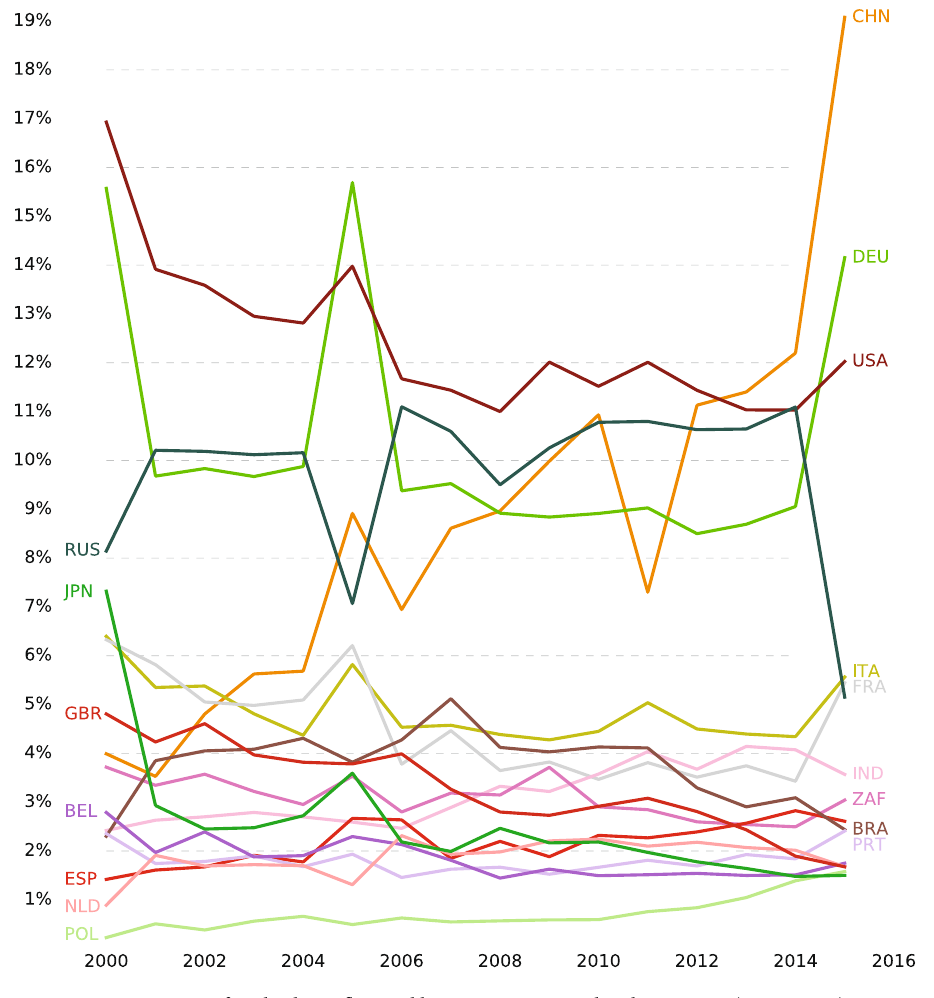
Figure 3. Percentage of multiplex influential betweenness centrality, by country